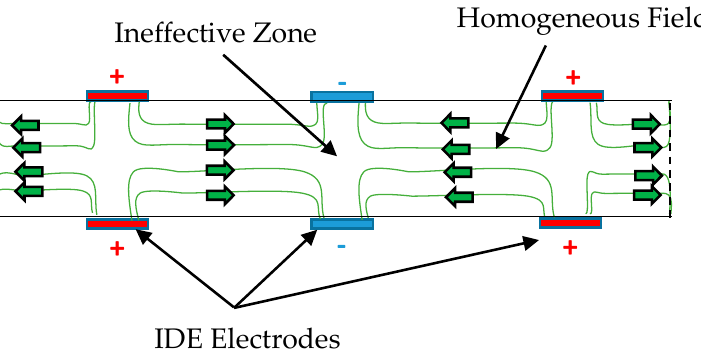
Figure 2. Sketch for the structure of homogenized MFC with interdigitated electrodes.